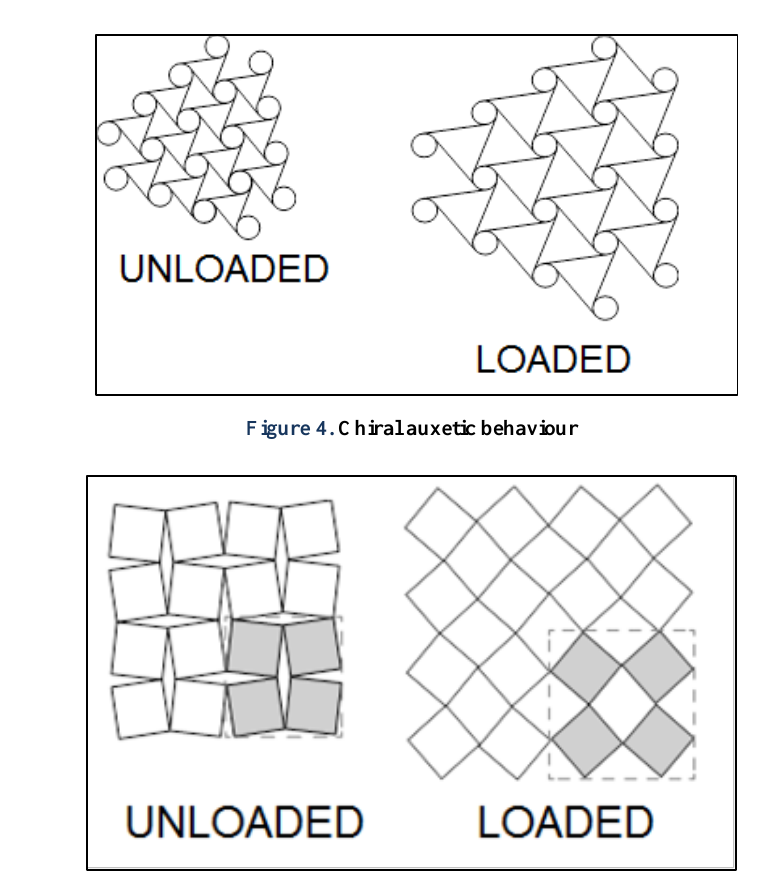
Figure 3. Re-entrant auxetic behaviour